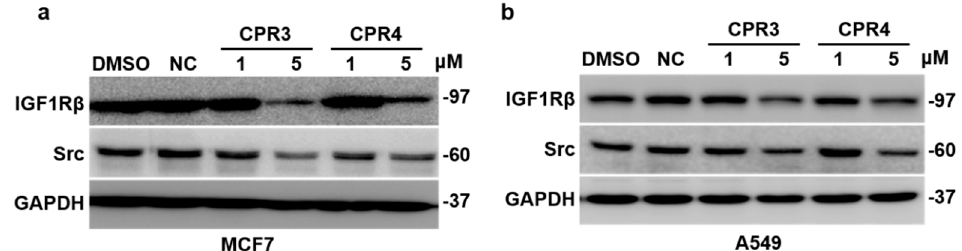
Figure 3. Immunoblotting for IGF-1R and Src in both MCF7 ( a ) and A549 ( b ) cells. The cells were treated with CPR3 or CPR4 at 1 and 5 µ M of concentration for 24 h. NC was used as a negative control (5 µ M). For detection of the protein expression, extracted lysate was incubated with IGF-1R or Src antibody for 1 h.